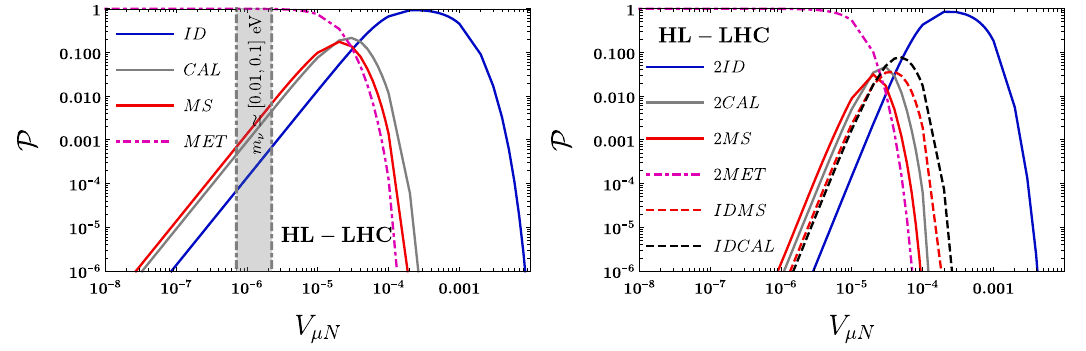
Fig. 6 Decay probability of one RHN (left) and two RHN (right) in different parts of the HL-LHC detector. For this figure, we consider M N = 20 GeV, M Z (cid:2) = 1 TeV. ID, MS, CAL and MET represent the decay of N in the inner detector, muon spectrometer, calorimeter and